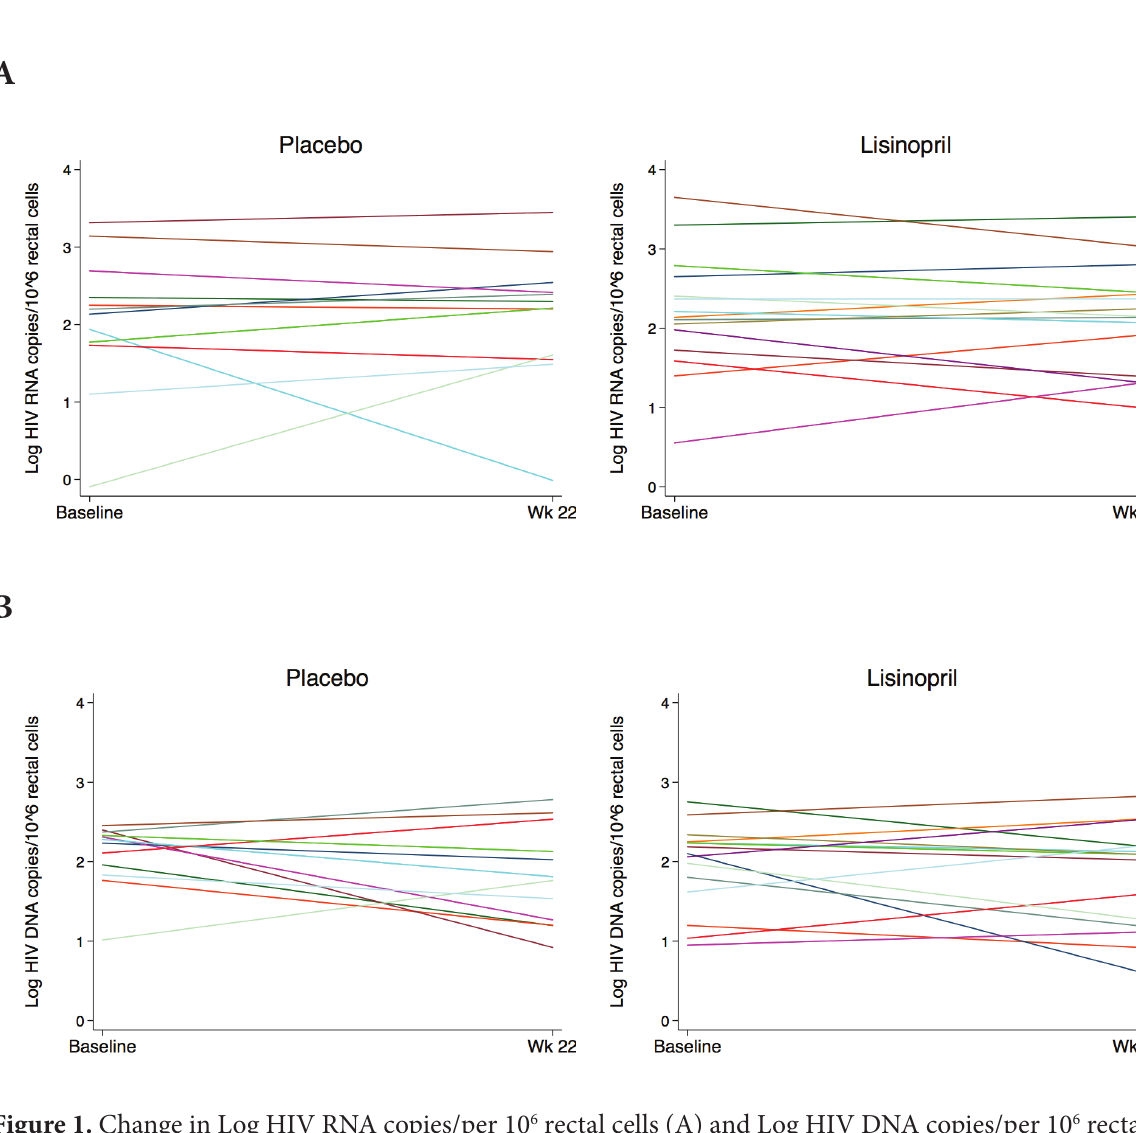
Figure 1. Change in Log HIV RNA copies/per 10 6 rectal cells (A) and Log HIV DNA copies/per 10 6 rectal cells (B) from baseline to Week 22 in the placebo and lisinopril treatment groups. Each line represents an individual